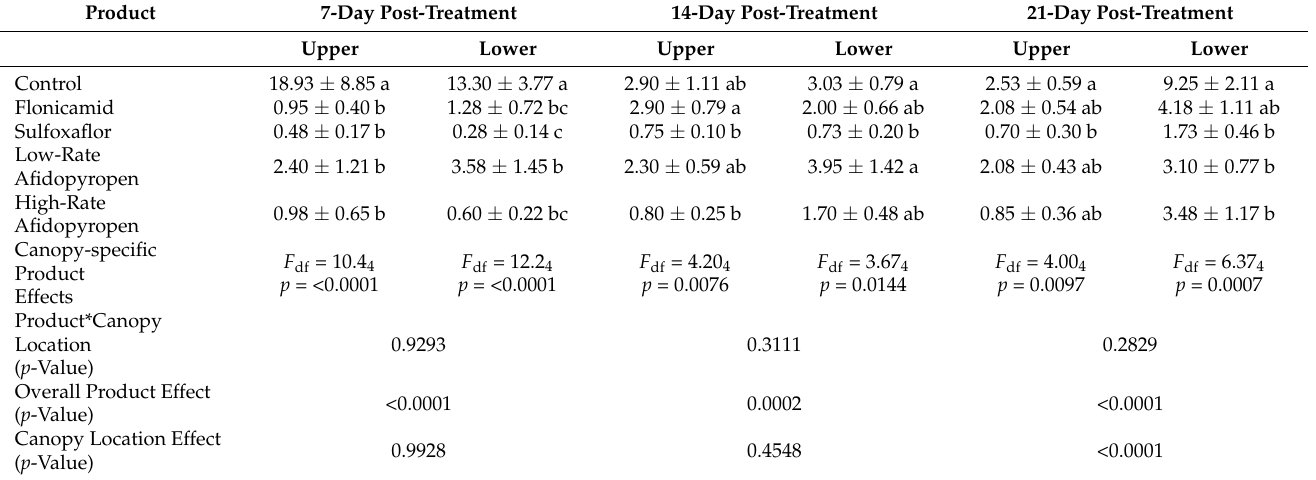
Table 1. Mean ± SEM of total pecan aphids per leaf across treatments and sample days in 2019. Differing letters in columns indicate a significant difference between treatments ( p < 0.05 Tukey’s honestly significant difference (HSD). Canopy-specific product effects and p -values for product*canopy interaction, overall product effect, and canopy location across sampling days are also shown. Application rates for each aphicide are based on the standard label rate.